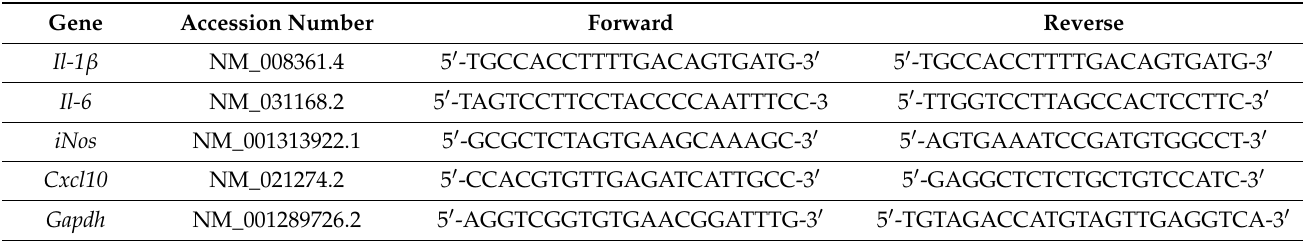
Table 1. The primer sequences and accession number of